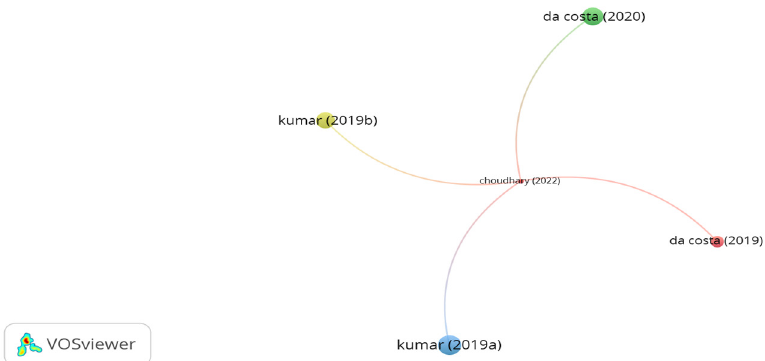
Figure 19. Network visualization of banana fibers.